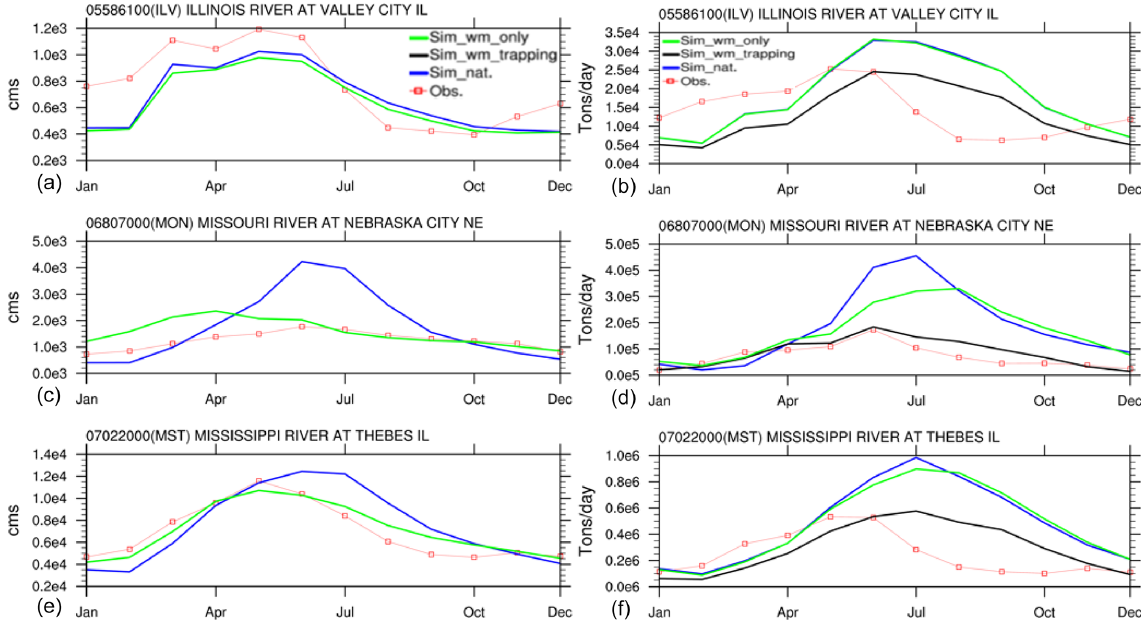
Figure 10. Simulated and observed mean monthly streamflow (a, c, e) and suspended sediment discharge (b, d, f) at three USGS gauges representative of different levels of flow